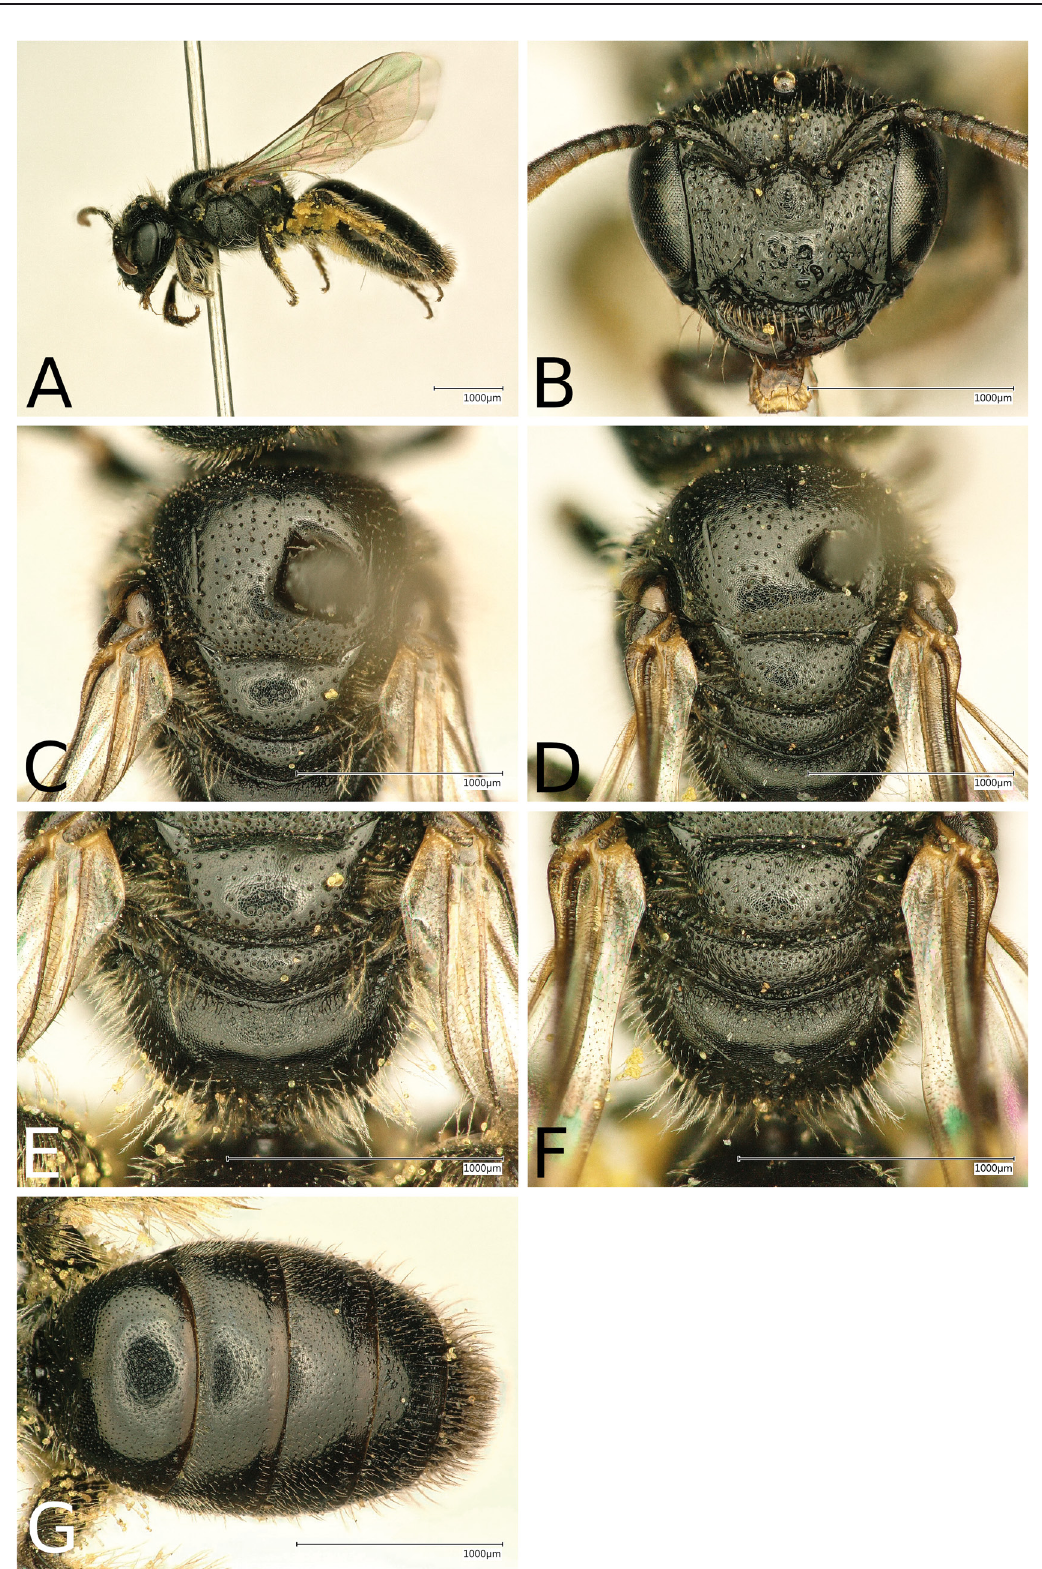
Fig. 6. Scrapter mellonholgeri Kuhlmann sp. nov., ♀, paratype (RCMK). A . Lateral view. B . Head. C–D . Scutum and scutellum (dorsal view). Variation of sculpture. E–F . Metanotum and propodeum (dorsal view). Variation of sculpture. G . Metasoma (dorsal